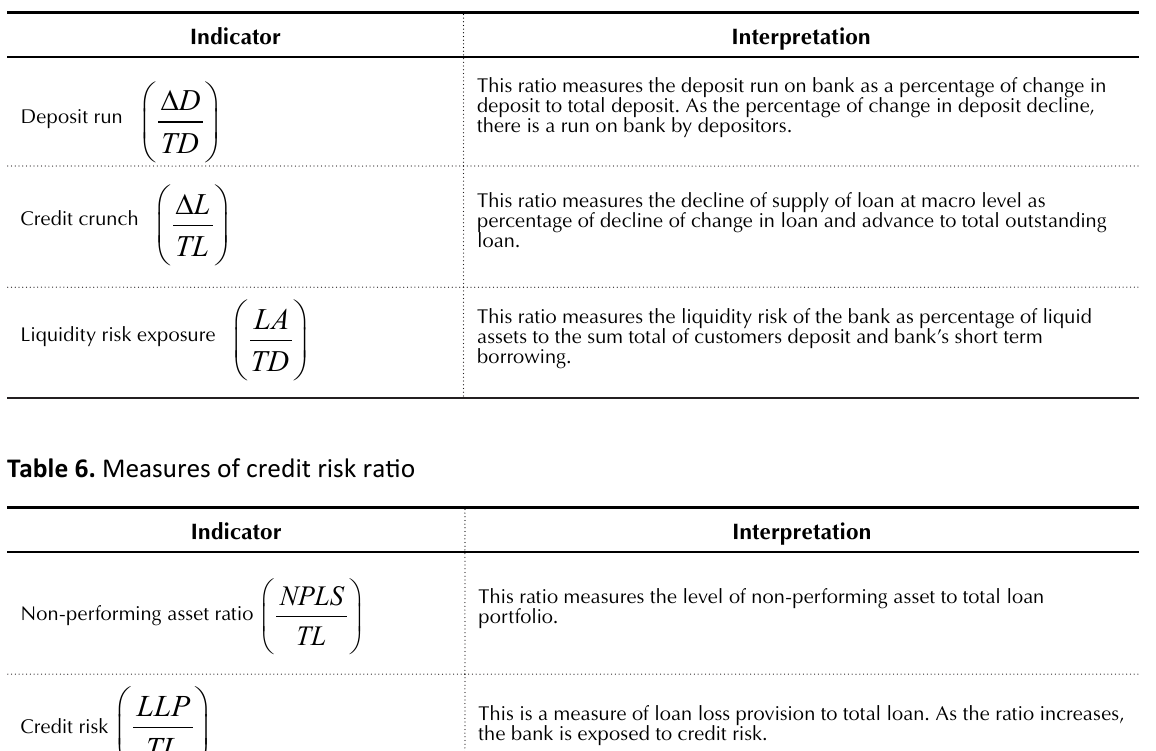
Table 5 . Measures of liquidity crunch ratio